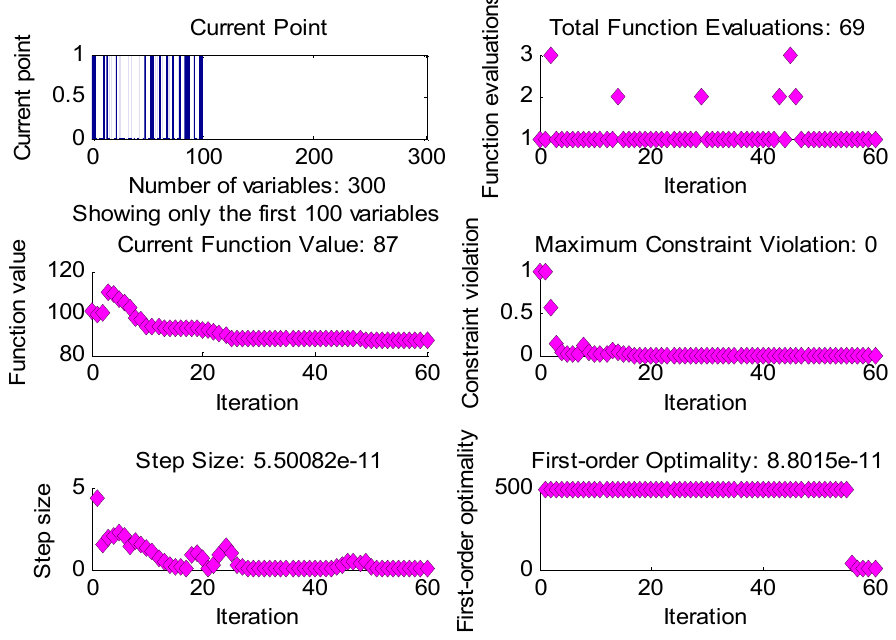
Figure 4. Convergence characteristics of RQP for the solution of the underdetermined nonlinear model.